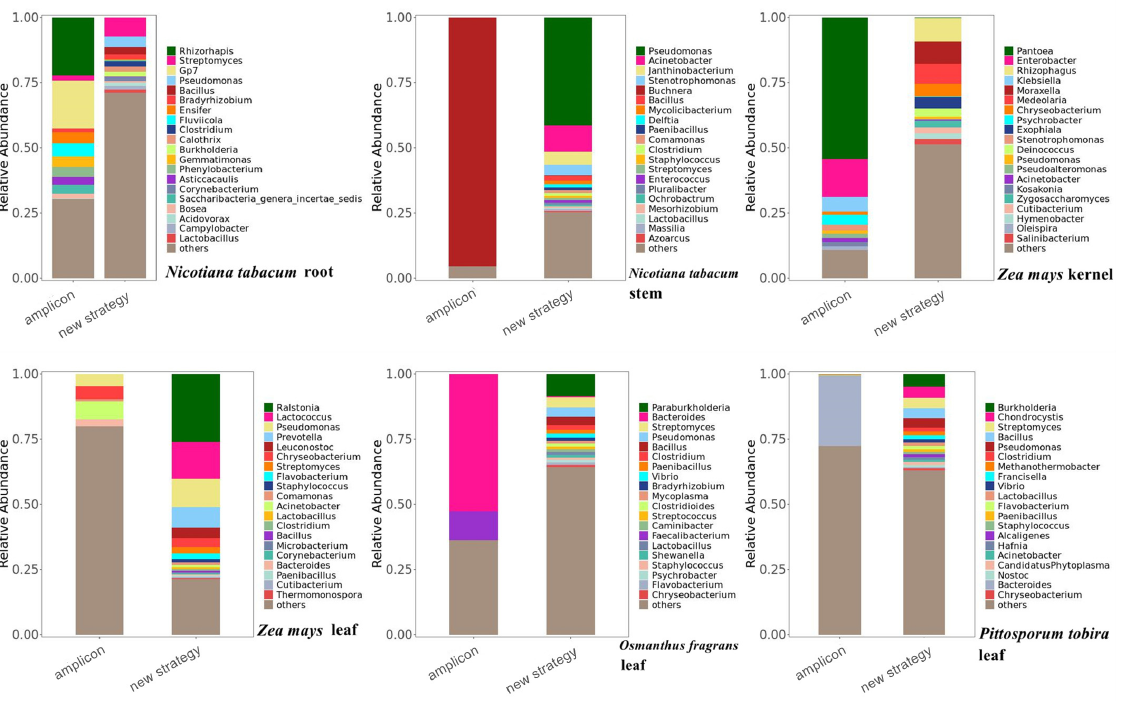
Figure 5. Bacterial community composition at the genus level with the two methods. The stack diagram shows that the abundance of bacteria obtained by the new analysis strategy is generally higher than that obtained by the amplicon sequencing